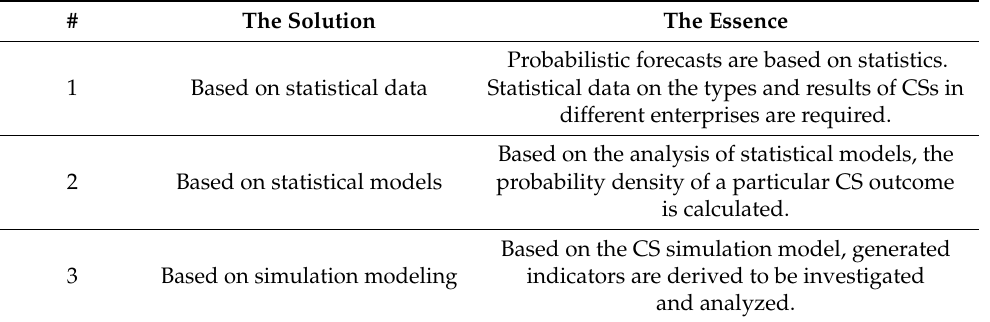
Table 2. Comparison of solutions to CS variability